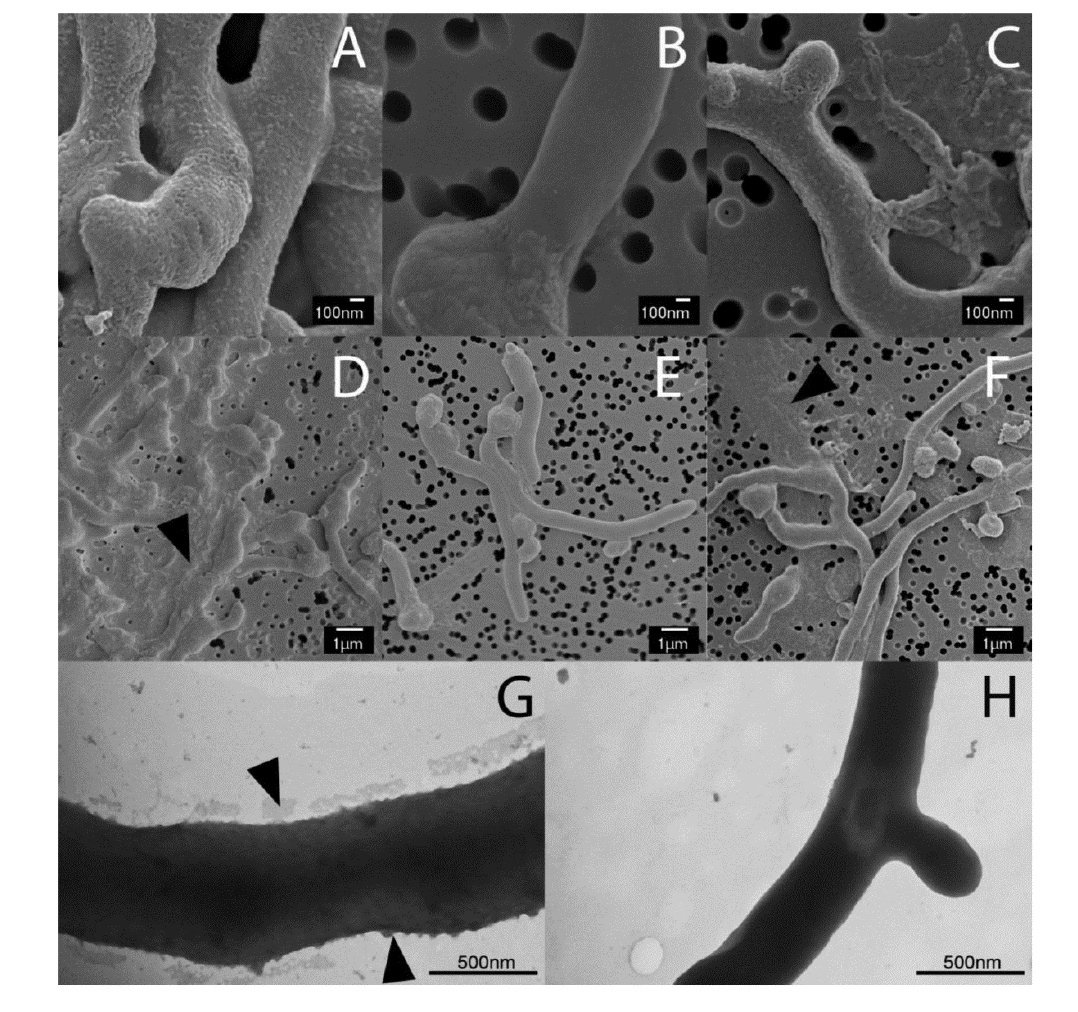
FIGURE 1: Electron micrographs revealing at Mat-dependent extracellular matrix. Scanning electron micrographs of young vegetative my- celium (A-F) show an abundance of extracellular material covering the hyphae of wild-type S. lividans (A) and between hyphae ( D , indicated by arrow). This extracellular material was also present in the cslA null mutant ( C and F , indicated by arrow), but was absent in matAB null mutants ( B and E ). Negatively stained hyphae with tungsten acid, specific for polymeric substances, revealed a scabrous outside coating in wild-type hyphae (G) that is absent in the mat mutant (H) . All strains were grown for 8 h in TSBS media in shake